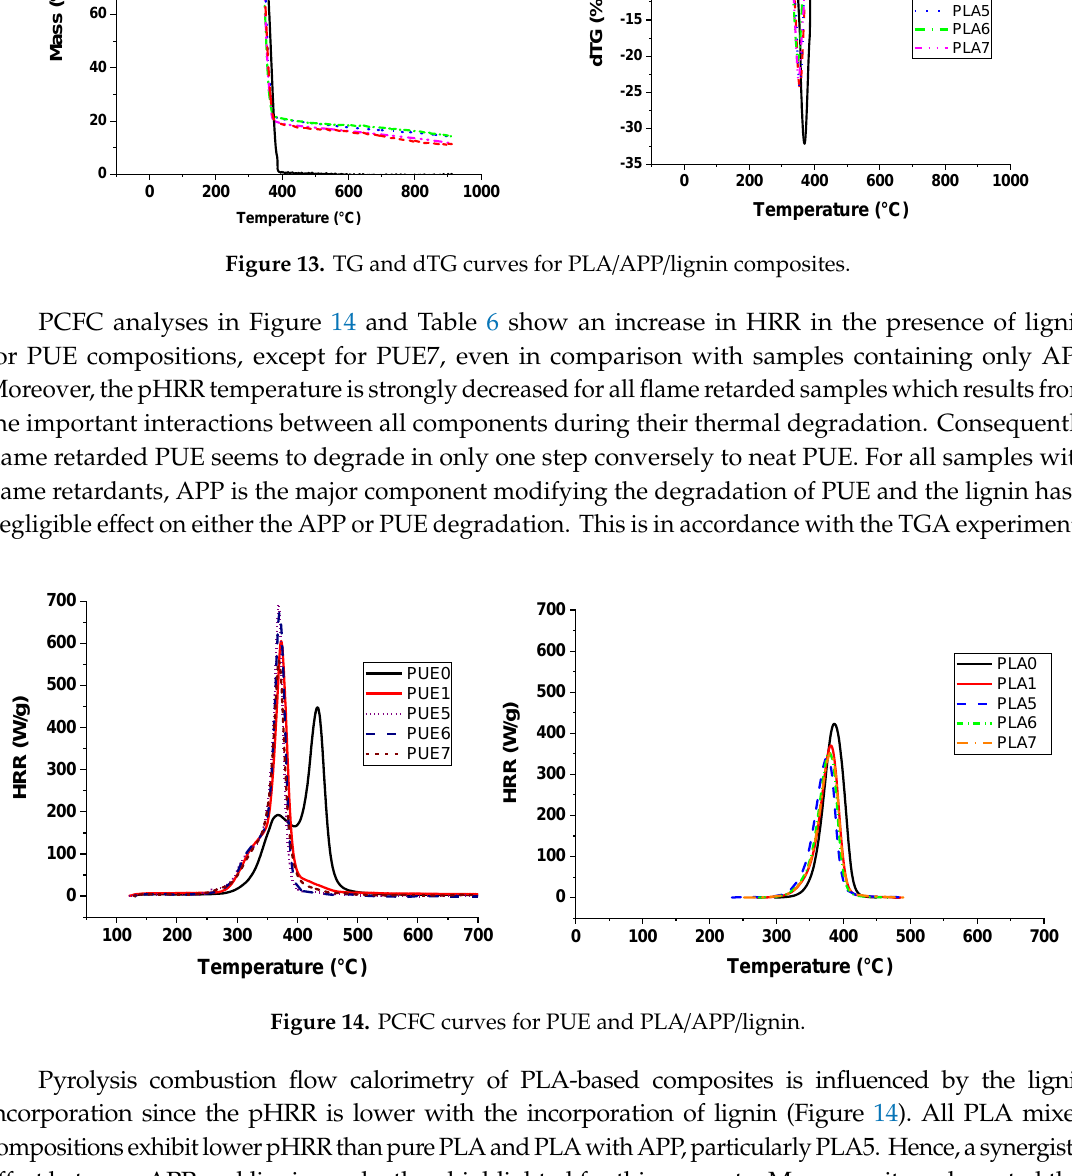
Figure 12. TG and DTG curves for PUE/APP/lignin composites.